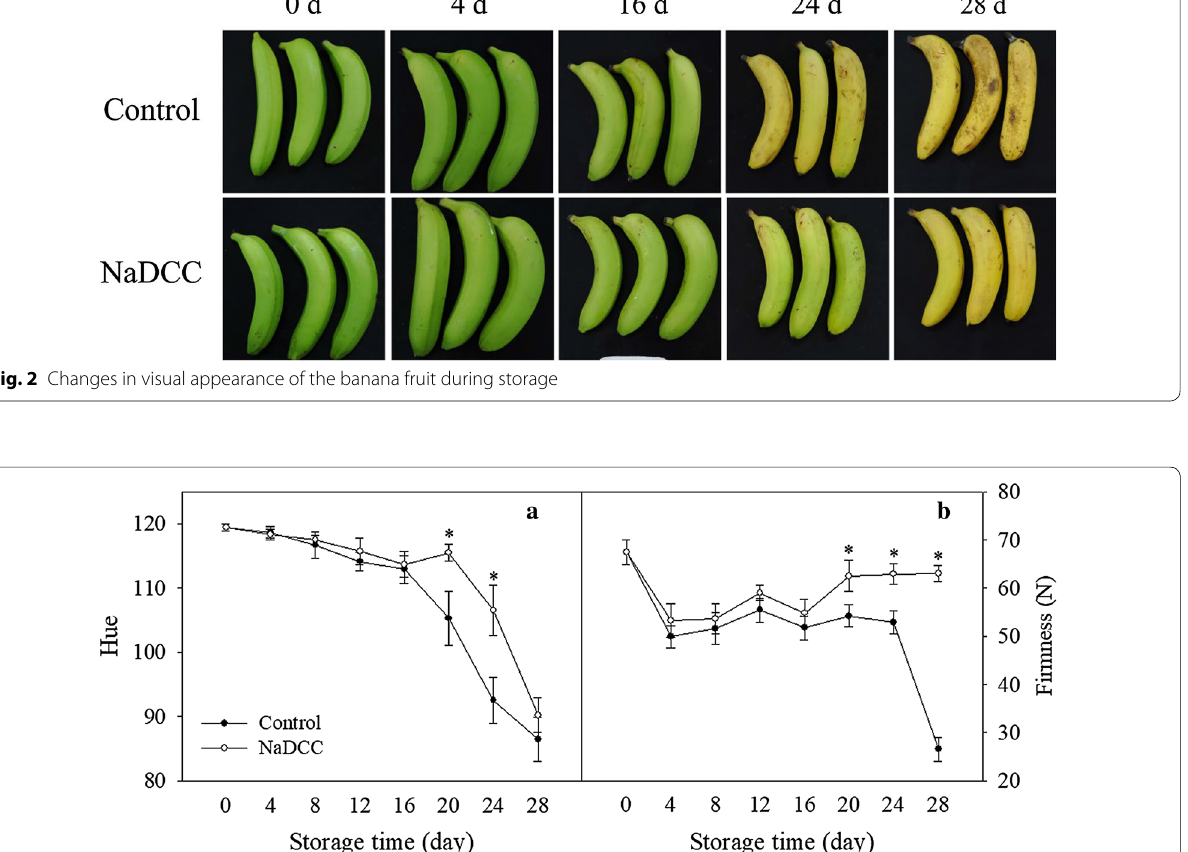
Fig. 3 Changes in hue angle ( a ) and fruit firmness ( b ) of banana fruit during storage. Data presented are means (from three separate groups) standard errors (n 3). The asterisks above bars represent a significant difference ( p < 0.05) ± =